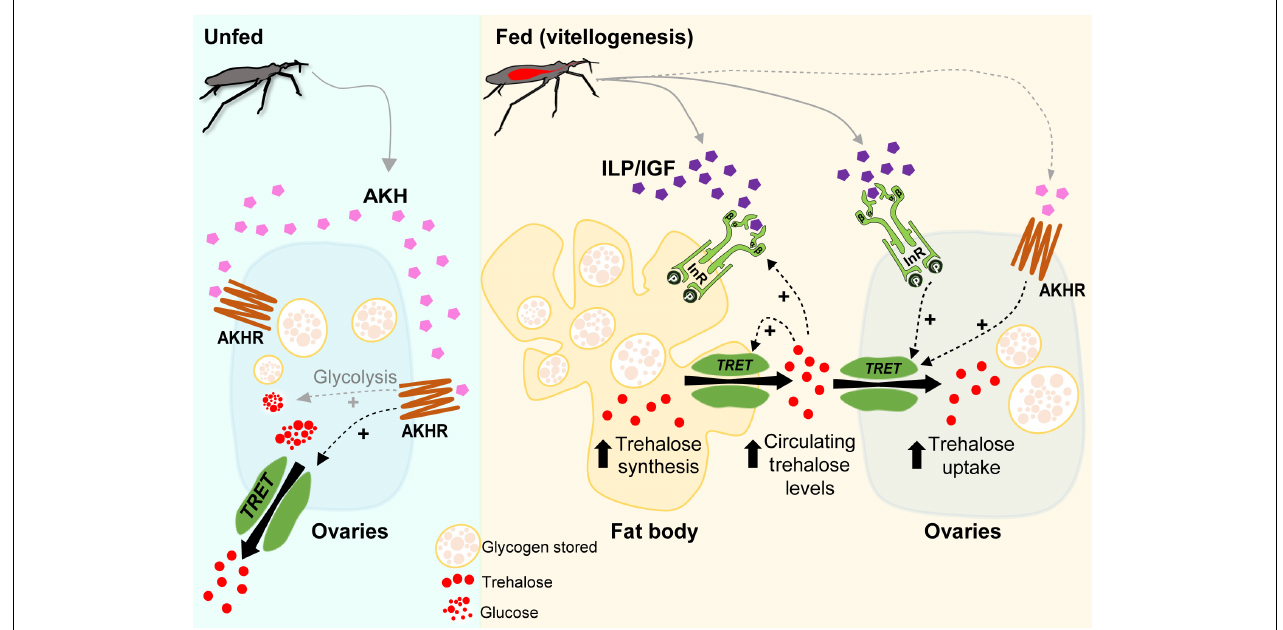
FIGURE 9 | Model of a potential regulatory pathway involved in Rhopr-TRET transcript expression in the fat body and ovaries of females of Rhodnius prolixus during unfed and fed stages. In R. prolixus , after a blood meal, we propose that insulin signaling is activated in ovaries and fat body and, along with other regulatory mechanisms, triggers vitellogenesis (Leyria et al., 2020a). Here, we demonstrate that trehalose content increases in the fat body and ovaries as days post-blood meal progress, as do the circulating levels in the hemolymph. We suggest that insulin-signaling activation, via Rhopr-IR1 (InR), is involved in Rhopr-TRET transcript expression that could then result in mediating a TRET facilitated bidirectional transfer of trehalose; the release of trehalose from the fat body and the uptake by the ovaries, satisfying the physiological needs required for egg formation. The potential up-regulation of Rhopr-TRET transcript via Rhopr-AKH signaling during vitellogenesis is also suggested, as well as a positive feedback of hemolymph trehalose levels on insulin signaling. In the unfed condition, Rhopr-AKH signaling might be involved in the release of trehalose from ovaries via Rhopr-TRET, thereby providing a source of energy for the insect during stressful situations such as starvation. The role of AKH signaling in promoting the glycolysis in unfed conditions to generate glucose as an energy source and/or trehalose to carbohydrate mobilization, as well as the release of Rhopr-ILP1/Rhopr-IGF and Rhopr-AKH after feeding, are assumed (gray dashed arrows). Rhopr-AKHR (AKHR).